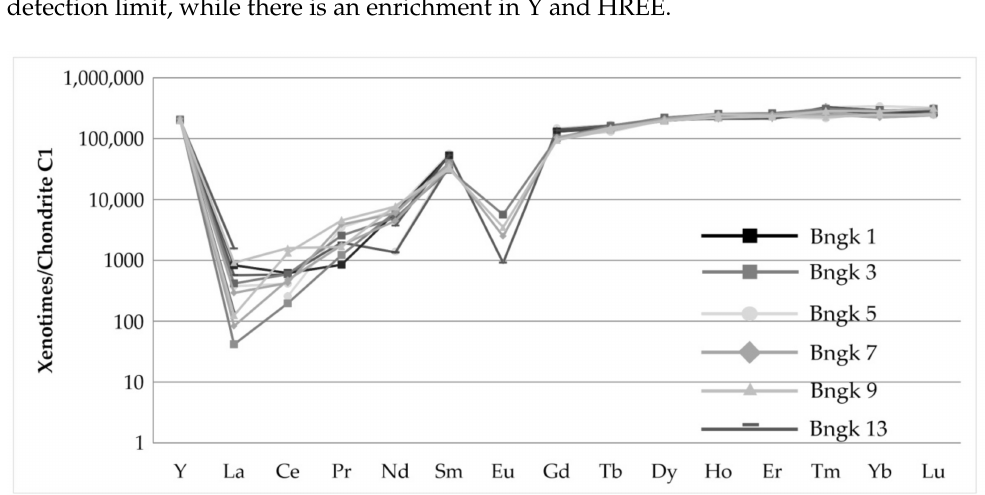
Figure 7. Chondrite-normalized REE patterns for selected xenotime from samples. Chondrite data are from